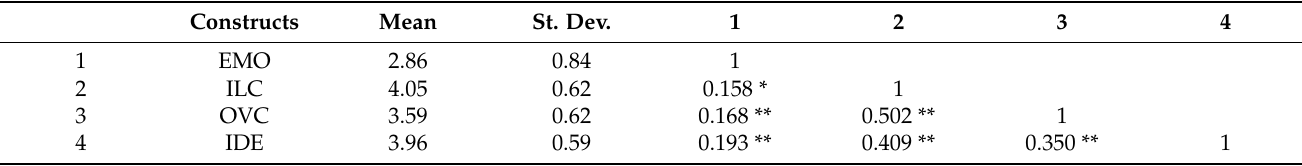
Table 2. Mean, standard deviation, and correlations.